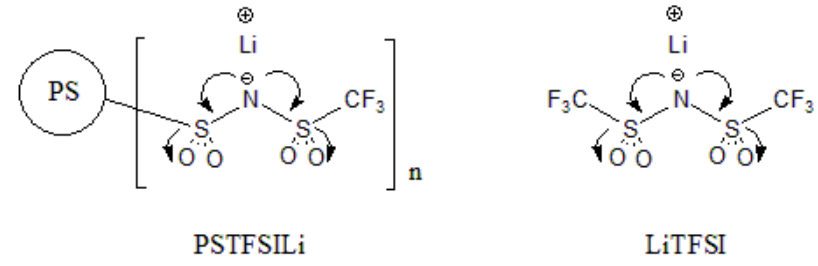
Figure 15. Structural comparisons of PSTFSILi with LiTFSI.